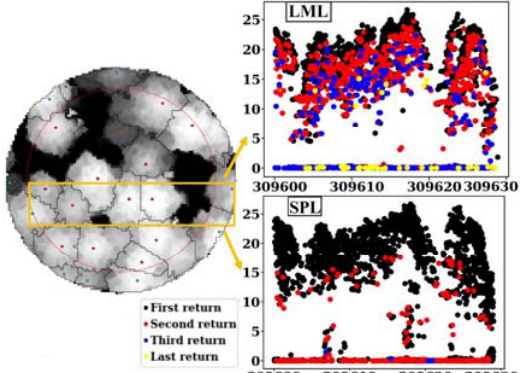
Figure 2. Delineated tree crowns with treetops with canopy height model (CHM) derived from linear mode laser (LML) data in the background (left) together with 2D (X and Z) plot of point clouds from LML and single-photon laser (SPL) data inside the orange rectangle shape in the middle of plot (right). Number of points inside this orange intersecting rectangle was 3,180 (54.3%, 32.5%, 11.5%, 1.6%) and 3,167 (90.6%, 9.3%, 0.1%, 0.0%) in LML and SPL (proportion of first, second, third, and last return), respectively. This plot contains spruce